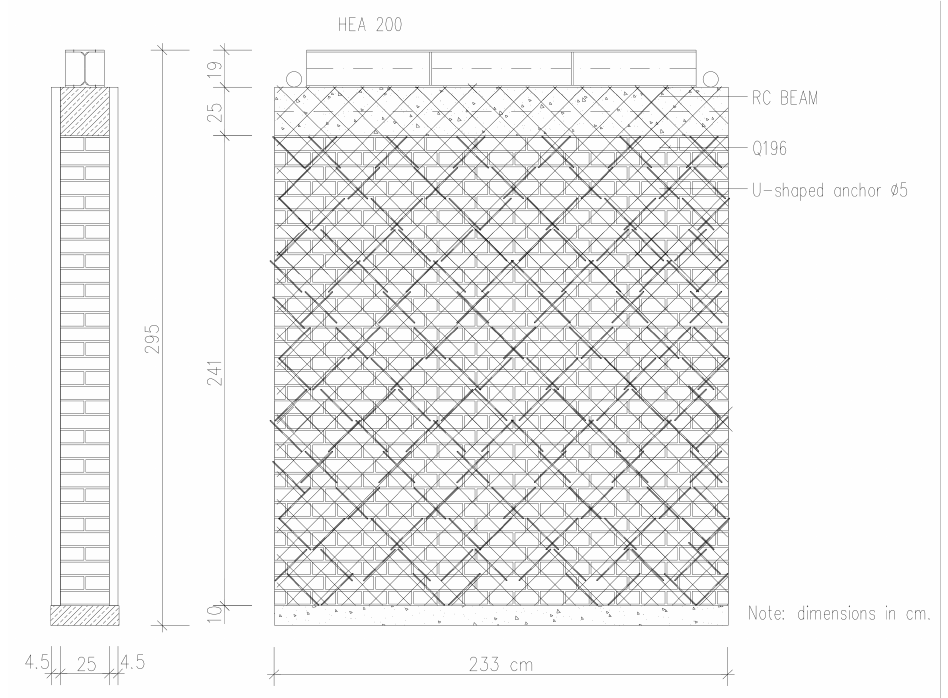
Figure 4. Distribution of anchors and geometry of the strengthened wall—strengthening Type